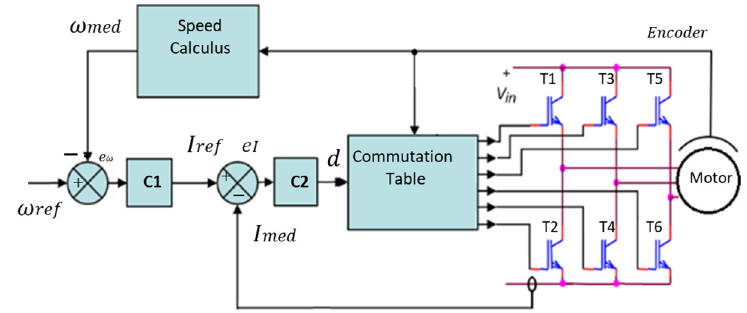
Figure 2. Control loop used in BLDC motors.